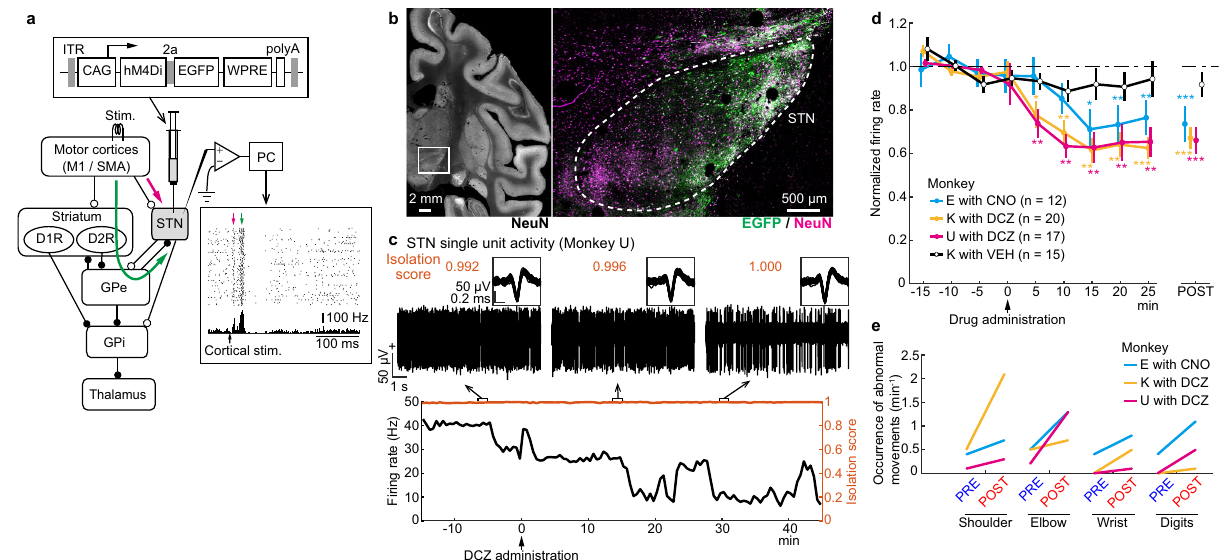
Fig. 1 Reduction of STN activity using DREADD. a The motor subregion of the STN was identi fi ed by the characteristic biphasic excitation (bottom right inset) induced by motor cortical stimulation, followed by infusion of an AAV vector co-expressing hM4Di and EGFP (top inset). Magenta and green arrows indicate early and late excitation. b Histologic con fi rmation of AAV transduction with anti-GFP (green) and NeuN (magenta) antibodies in monkey K. The brain region indicated by an open box on the left is enlarged on the right. The immunostaining was repeated twice with similar results. c Firing rate changes (bottom, black) and Isolation scores (brown) of a STN neuron with DCZ administration. Overlay of 50 isolated spikes (inset) and raw extracellular signals (top) at indicated time points are also shown. d Time course of effects of CNO (1.0 mg/kg, i.v.), DCZ (0.1 mg/kg, i.m.), or vehicle (VEH) on baseline fi ring rates of STN neurons. STN activity was normalized based on activity during the PRE period (from − 15 to 0 min) and averaged in 5-min bins (left) and in the POST periods (right; from 15 to 25 min after CNO administration; from 10 to 25 min after DCZ/VEH administration). Firing rates signi fi cantly decreased at 15, 20, and 25 min ( P = 0.01, 0.004, and 0.004, respectively; one-tailed Wilcoxon-signed rank test with Bonferroni correction) and in the POST (0.0005; two-tailed Wilcoxon-signed rank test) after CNO in monkey E, at 5, 10, 15, 20, and 25 min (0.02, 0.001, 0.001, 0.001, and 0.0007) and in the POST (0.0002) after DCZ in monkey K, and at 5, 10, 15, 20, and 25 min (0.005, 0.002, 0.003, 0.009, and 0.003) and in the POST (0.0004) after DCZ in monkey U. Error bars indicate SEM. * P < 0.05, ** P < 0.01, *** P < 0.001. e Occurrence of abnormal movements at rest during the PRE and POST (from 20 to 60 min after CNO/DCZ administration) periods, quanti fi ed from a single session in each